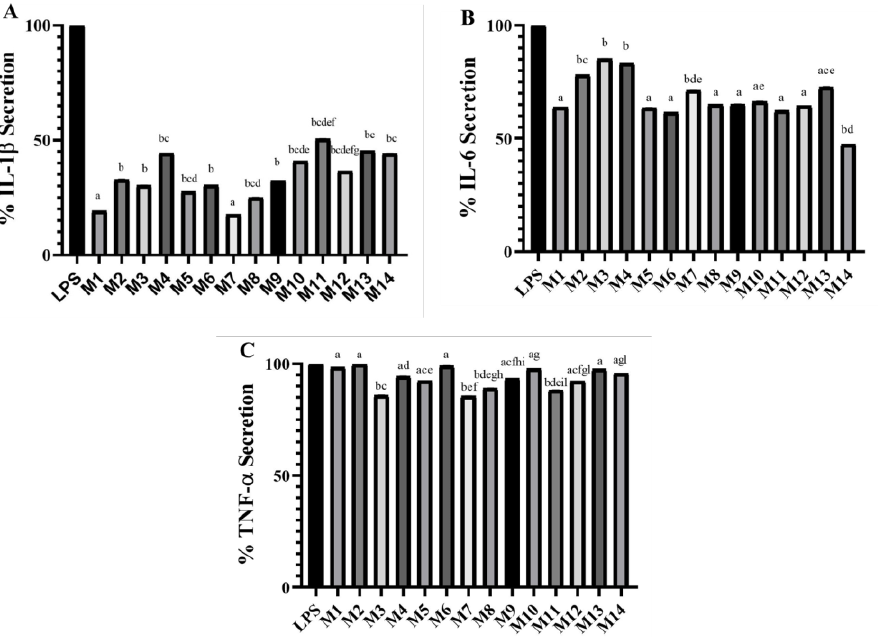
Figure 3. Percentage of secretion of IL-1 β ( A ), IL-6 ( B ), and TNF- α ( C ) from LPS-stimulated THP-1-derived macrophage cells after 24 h of treatment with M1-M14 extracts. Different letters within each column indicate statistically significant differences at p ≤ 0.05 in an ANOVA + Tukey’s pairwise t -test